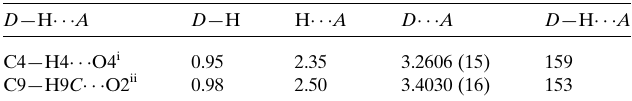
Table 2 Hydrogen-bond geometry (A˚ , (cid:2) ) for (II).